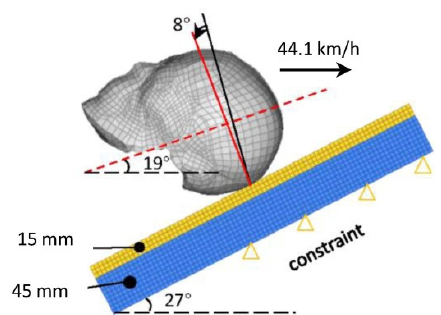
Figure 4. Setup of head-ground impact FE model. Black solid line is the parallel line of the vertical plane, and red solid line is that of the brain sagittal plane after rotating 8 ◦ . Red dotted line is located in the coronal plane of the head. The size of the ground is 500 × 500 × 60 mm.